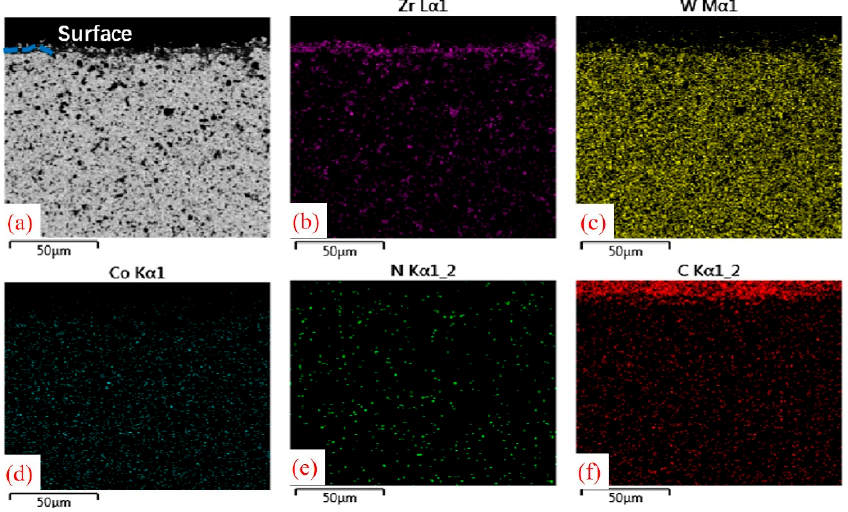
Figure 2. Microstructure and EDS element mapping of FC5-2, ( a ) microstructure, and ( b – f ) respective element mappings of Zr, W, Co, N, and C.